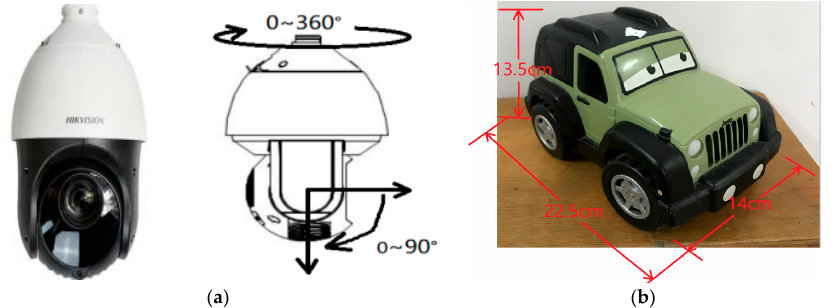
Figure 10. Experimental equipment. ( a ) Active camera with pan and tilt functions. ( b ) Wireless remote-control Jeep car.